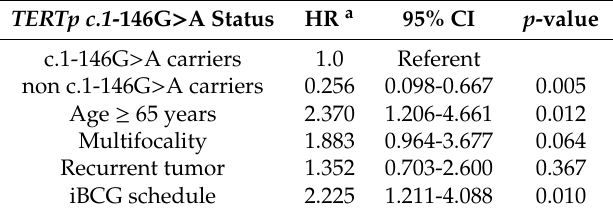
Table 5. Multivariate analysis and risk estimation of TERT c.1-146G > A mutation influence on BCG therapy outcome.